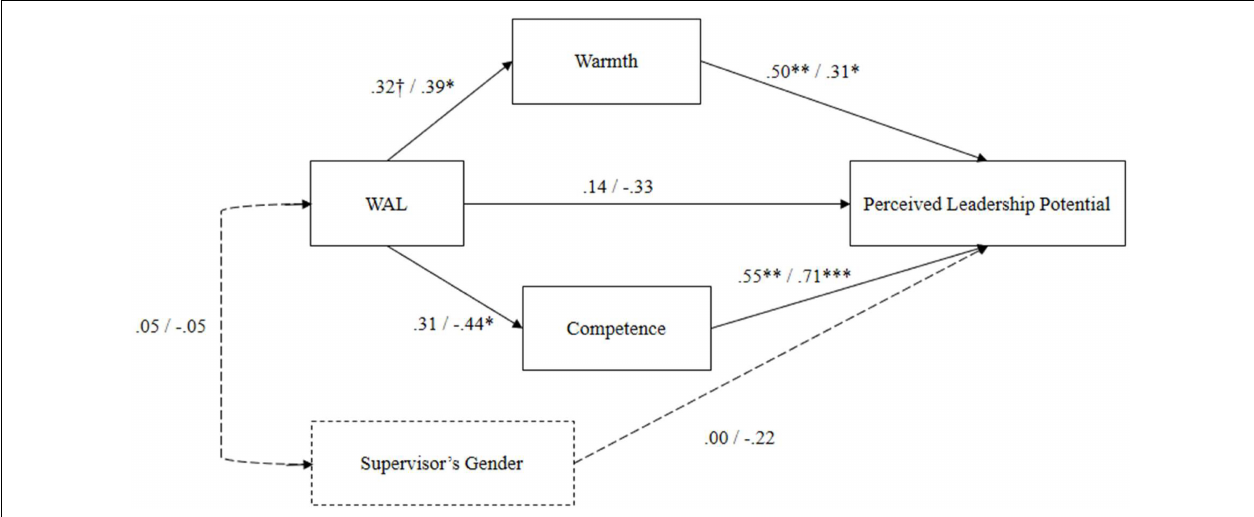
FIGURE 4 | Results of the multi-group SEM mediation model in Study 3. The first regression coefficient represents the standardized regression weight under the unconstrained model for the female candidate; the second coefficient represents the same for the male candidate; error terms of warmth and competence were correlated; * p < 0.05, ** p < 0.01, *** p < 0.001, † p <